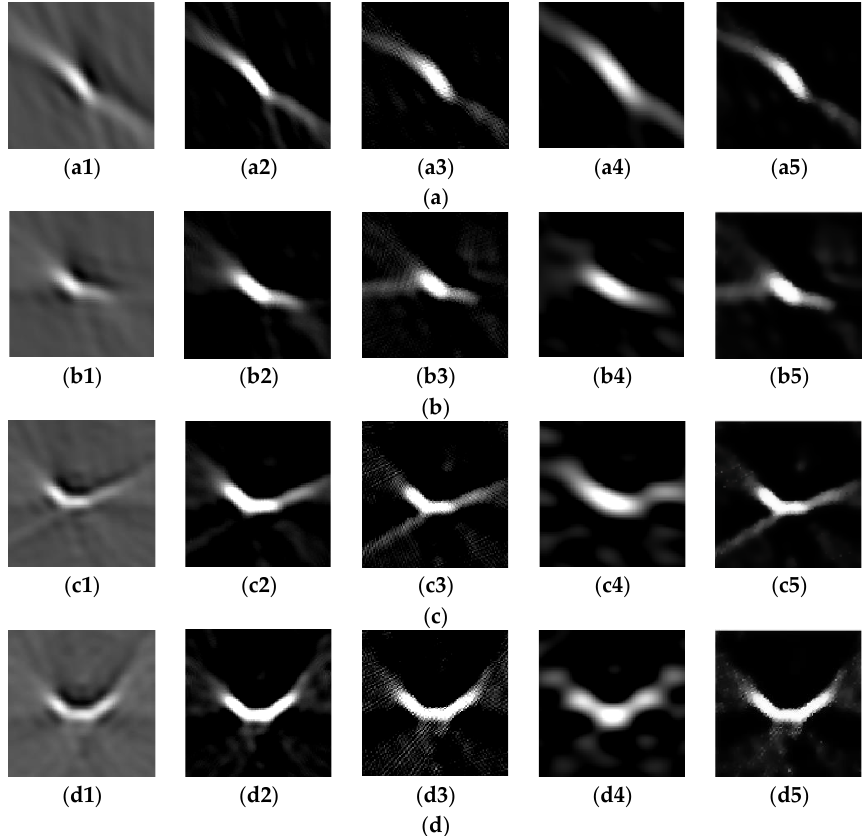
Figure 13. Far-field experimental imaging results under a limited view of projections ( Far left ) iRadon; ( Left ) FBP; ( Middle ) ART; ( Right ) sparse ART with OMP; ( Far right ) TV sparse reconstruction with ART. ( a ) 0–60 ◦ sampled data ( a1 – a5 ); ( b ) 0–90 ◦ sampled data ( b1 – b5 ); ( c ) 0–120 ◦ sampled data ( c1 – c5 ); ( d ) 0–150 ◦ sampled data ( d1 – d5 Table 6. CC values of different algorithms with incomplete views of projection.